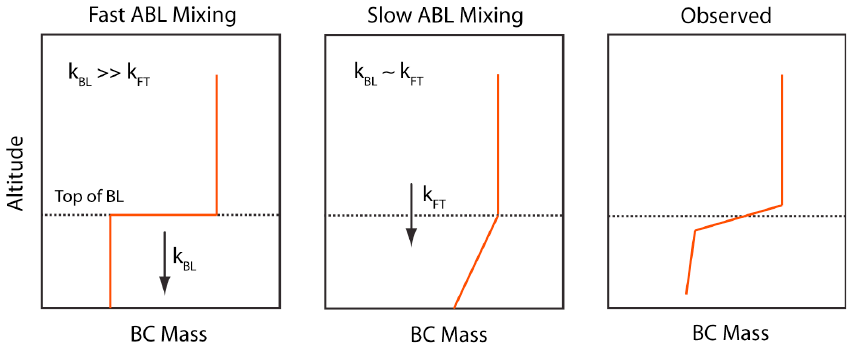
Fig. 9. Idealized and observed profiles in the springtime ABL. The first two profiles are idealized cases assuming BC mass is predominantly removed by dry deposition. The exchange coefficients k and k are inverses of the e-folding diffusion timescales for the ABL and the BL FT transition between the free troposphere and the ABL, respectively. In the first case, the boundary layer mixing is faster than mixing between the free troposphere and boundary layer. In the second case, the timescales for mixing from the free troposphere into the boundary layer are comparable to those in the boundary layer. The third panel generalizes the low-altitude BC profiles observed during ARCPAC.